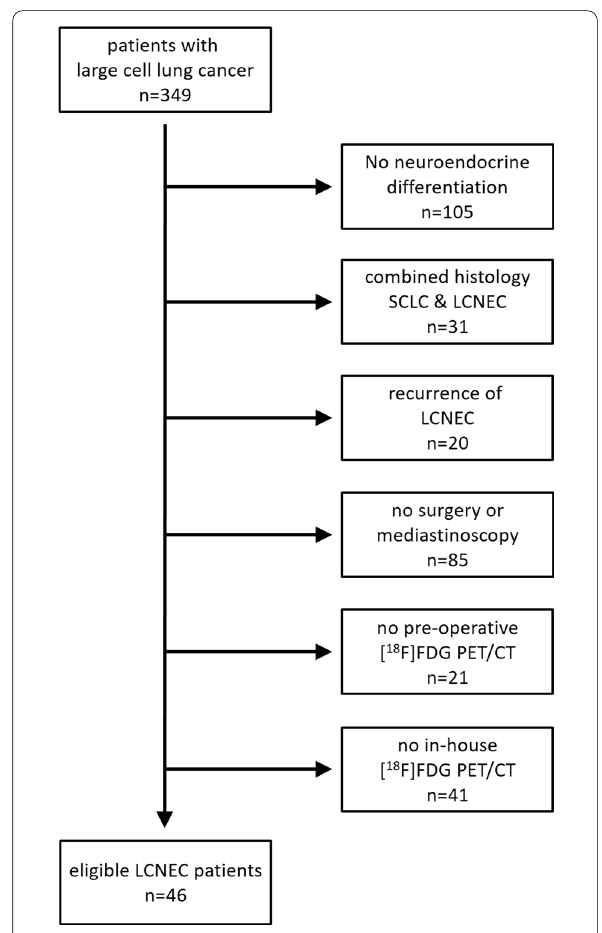
Fig. 1 Flowchart with patient selection